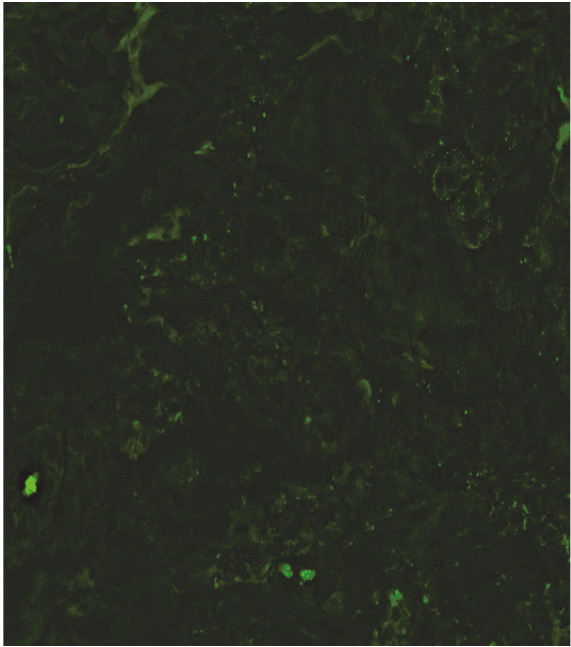
Figure 5: There is no glomerular deposition of complement component C1q present (immunofluorescent, x